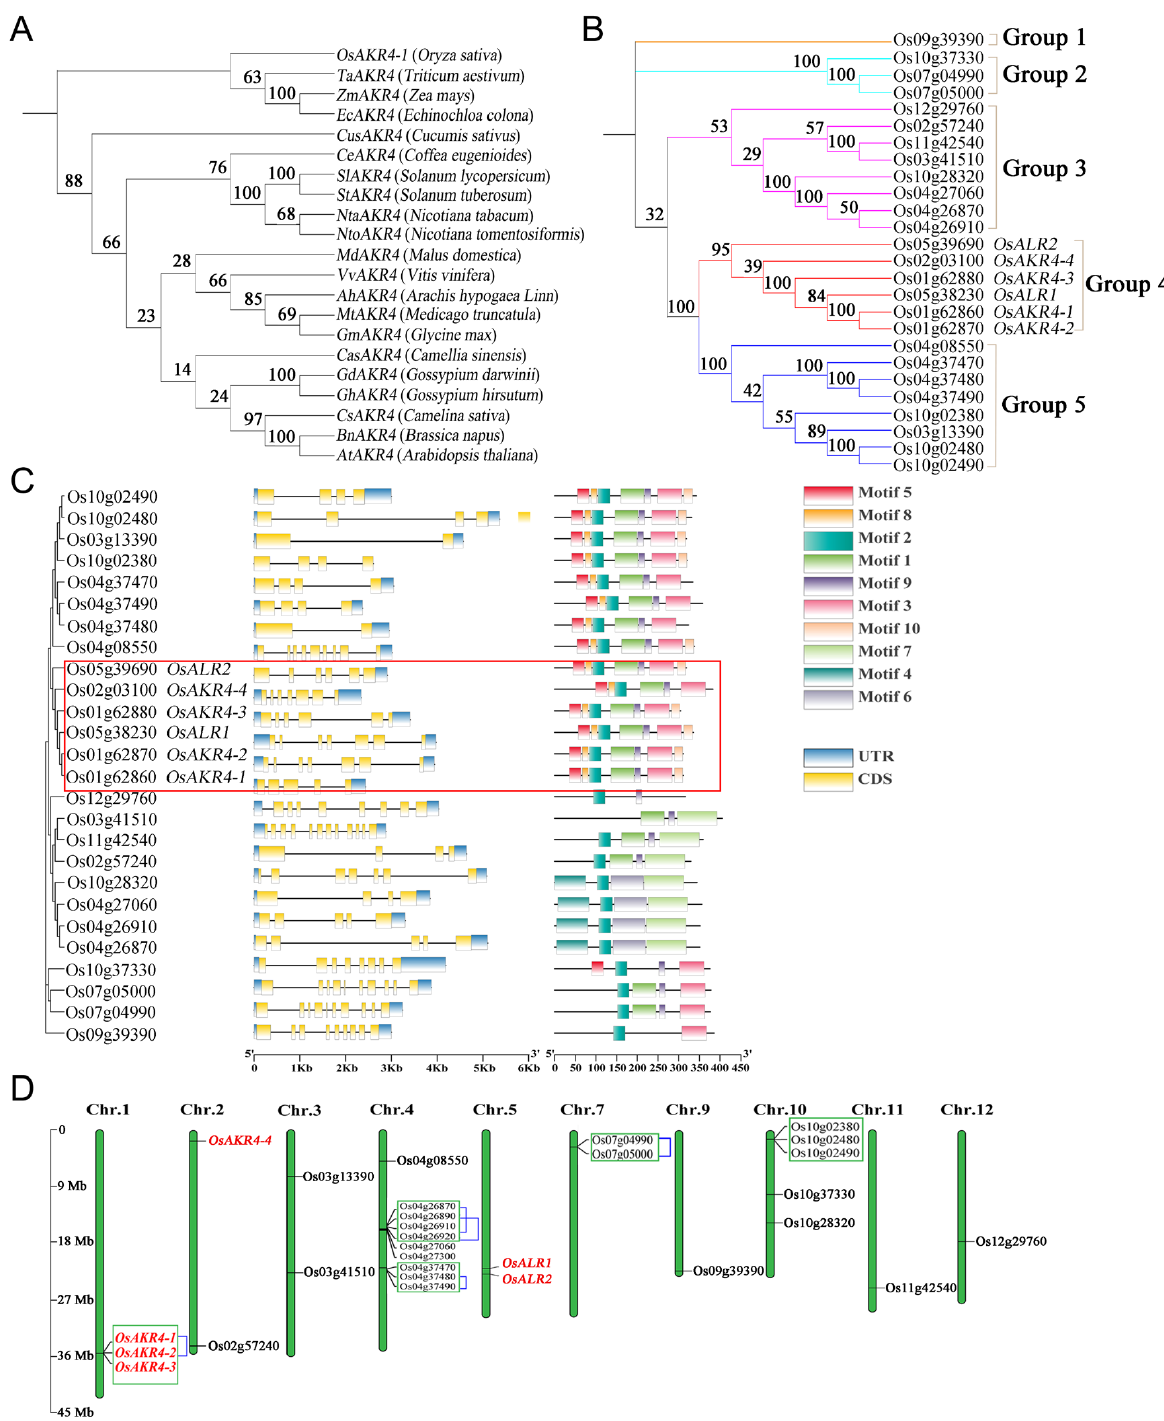
Figure 1. Bioinformatic analysis of AKR-family proteins. ( A ) Phylogenetic tree constructed from the amino acid sequences of the AKR4 family in 21 plants. ( B ) Phylogenetic tree constructed from the amino acid sequences of OsAKRs. The sequences to be aligned were confirmed using SMART (http://smart.embl.de/smart, accessed on 5 March 2022) and NCBI CDD (www.ncbi.nlm.nih.gov/cdd/, accessed on 5 March 2022). ( C ) The gene structure and motif of OsAKRs. The scale at the bottom represents the number of nucleotides or amino acids. ( D ) Distribution of OsAKRs among the rice chromosomes. The genes in the green box represent tandem-duplicated genes. The large-fragment duplication event occurs in the genes connected with blue lines.